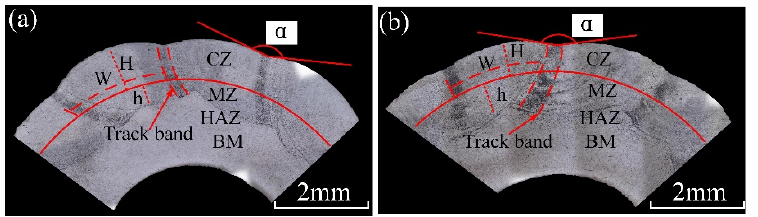
Figure 4. The cross-sectional images: ( a ) the underwater cladding layer; ( b ) the in-air cladding layer.